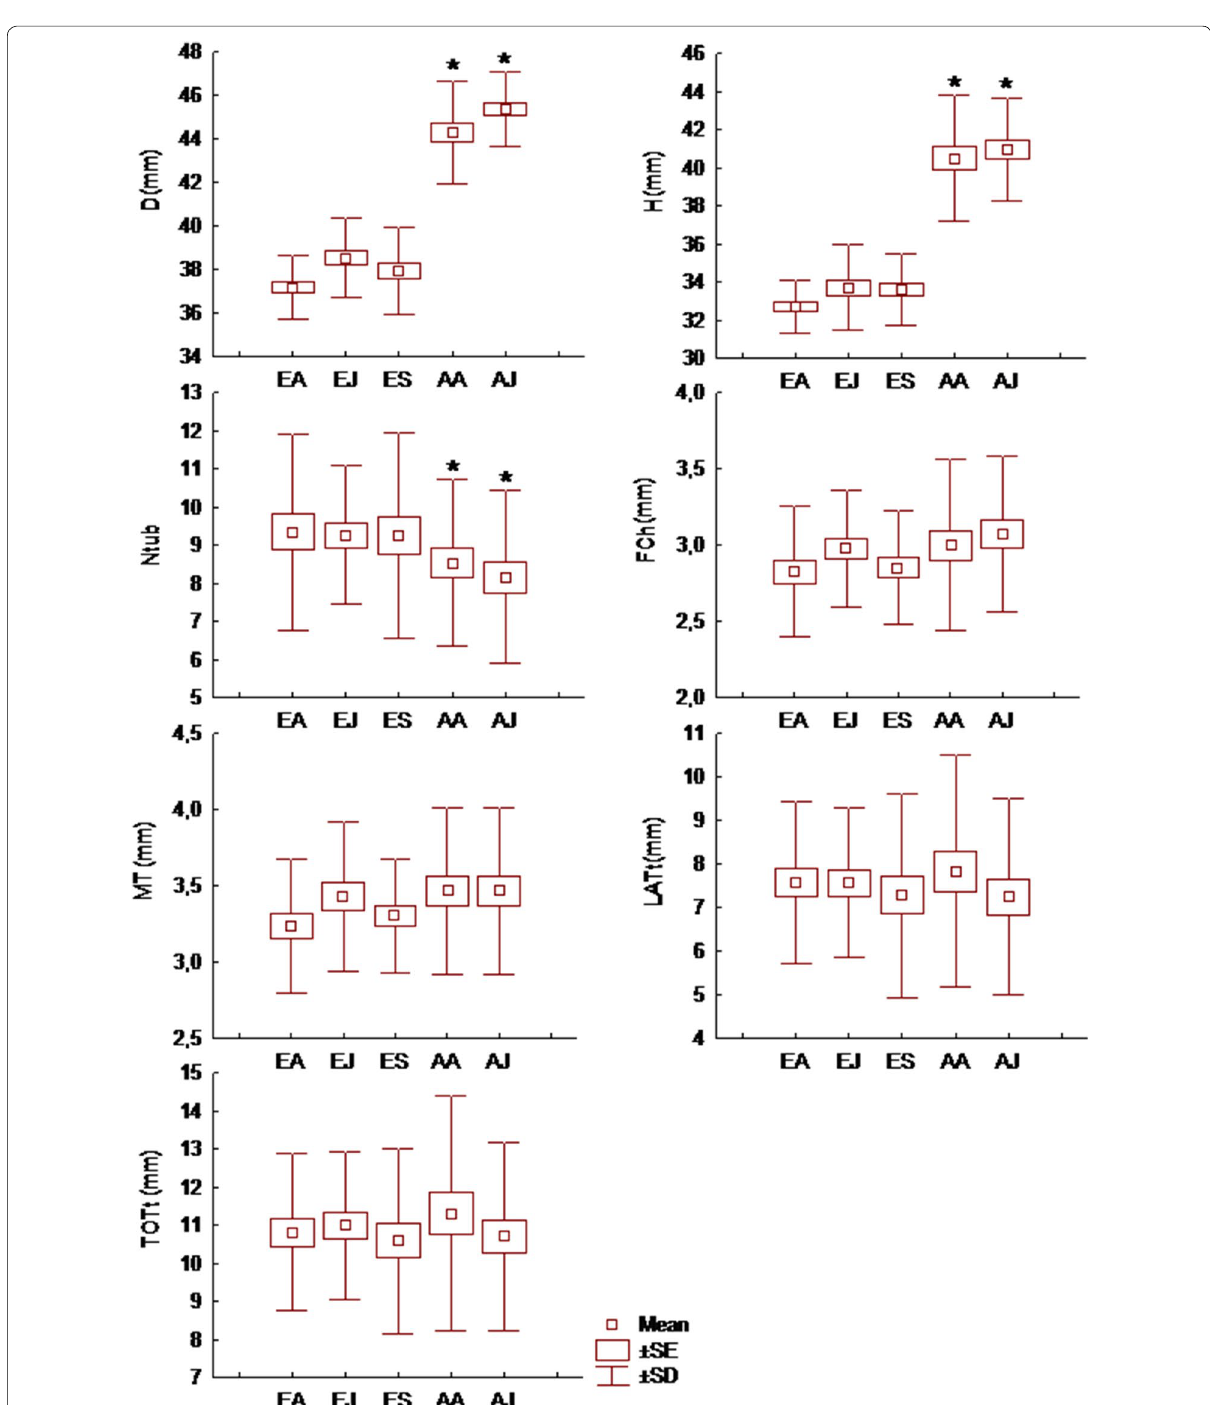
Fig. 1 Comparison of shell size and morphological characteristics of the FPSC of Helix lucorum between samples taken from the two study sites. D: shell diameter, H: shell height, Ntub: number of spermathecal tubules, F.Ch.: length of the fertilization chamber, M.T.: length of the main tubule, LAT.t: the cumulative length of lateral tubules, TOT.t: the cumulative length of all tubules. EA: Edessa-April, EJ: Edessa-June, ES: Edessa –September, AA: Axios-April, AJ: Axios-June. Asterisks indicate significant differences at p <